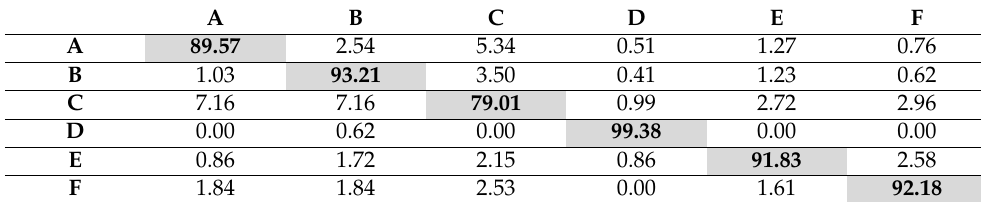
Table 10. Confusion matrix (%) of 3D ‐ DIDGP28 on Set 2 using Random Forest classifier. A Table 9. Confusion matrix (%) of 3D-DIDGP28 on Set 1 using Random Forest classifier.